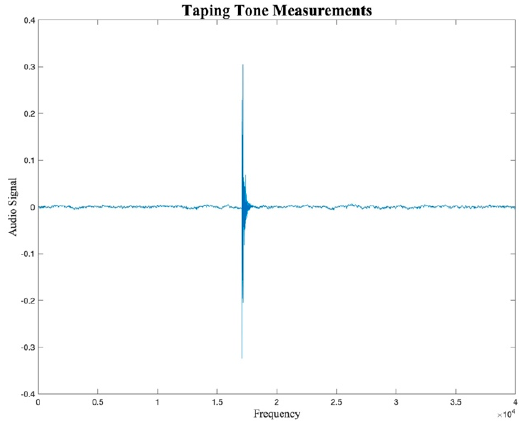
Figure 3. The taping tone measurements are shown in acoustic tracing.